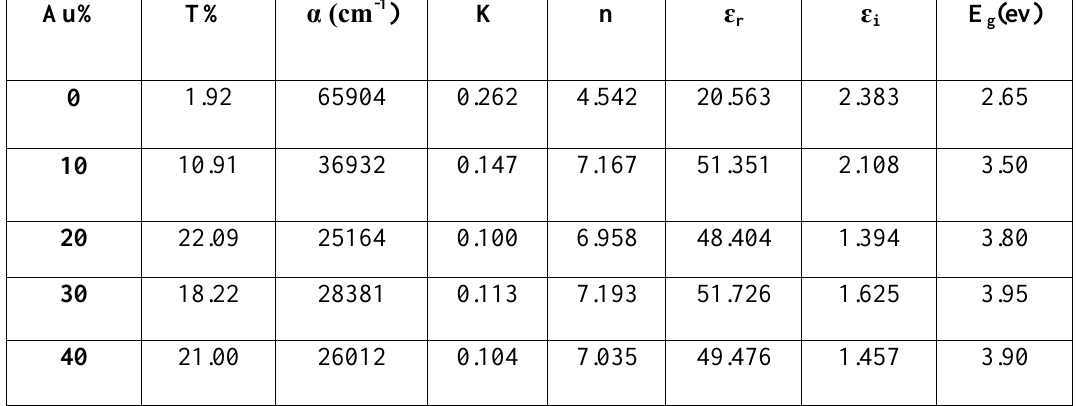
= 400 ˚C at λ = 500 a